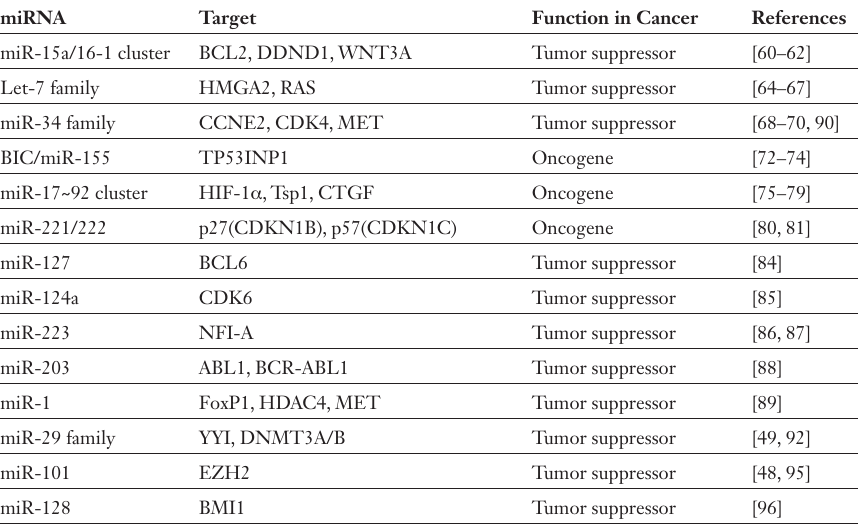
Table 1 miRNAs that are implicated in human cancer.